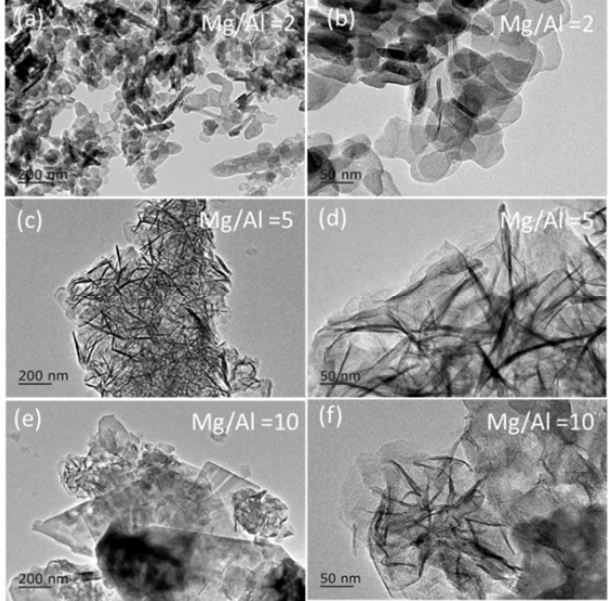
Figure 2. TEM images of Mg(Al)O LDHs with different Mg:Al molar ratios: ( a , b ) Mg:Al = 2:1; ( c , d ) Mg:Al = 5:1; ( e , f ) Mg:Al = 10:1.